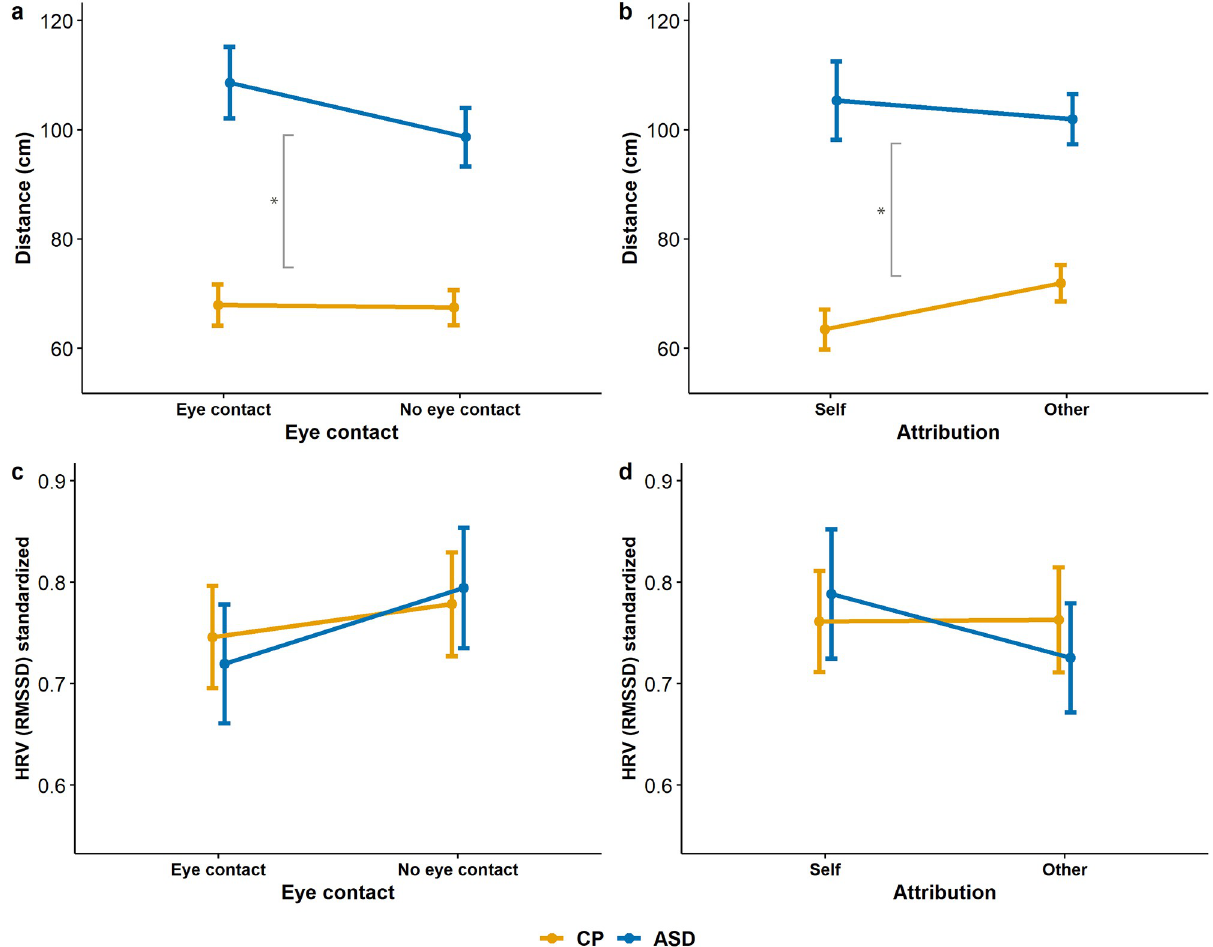
Fig 4. Interpersonal distance and HRV differences in different conditions. Panel a-b Interpersonal distance in cm. Panel a: With or without eye contact, Panel b: Attribution to self or the other. Panel c-d Heart rate variability in explicit conditions at a reported distance. Panel c: With or without eye contact, Panel d: Attribution to self or the other. Error bars: standard error of the mean. Asterisks indicate significant group differences. Orange line: control participants, blue line: participants with ASD.